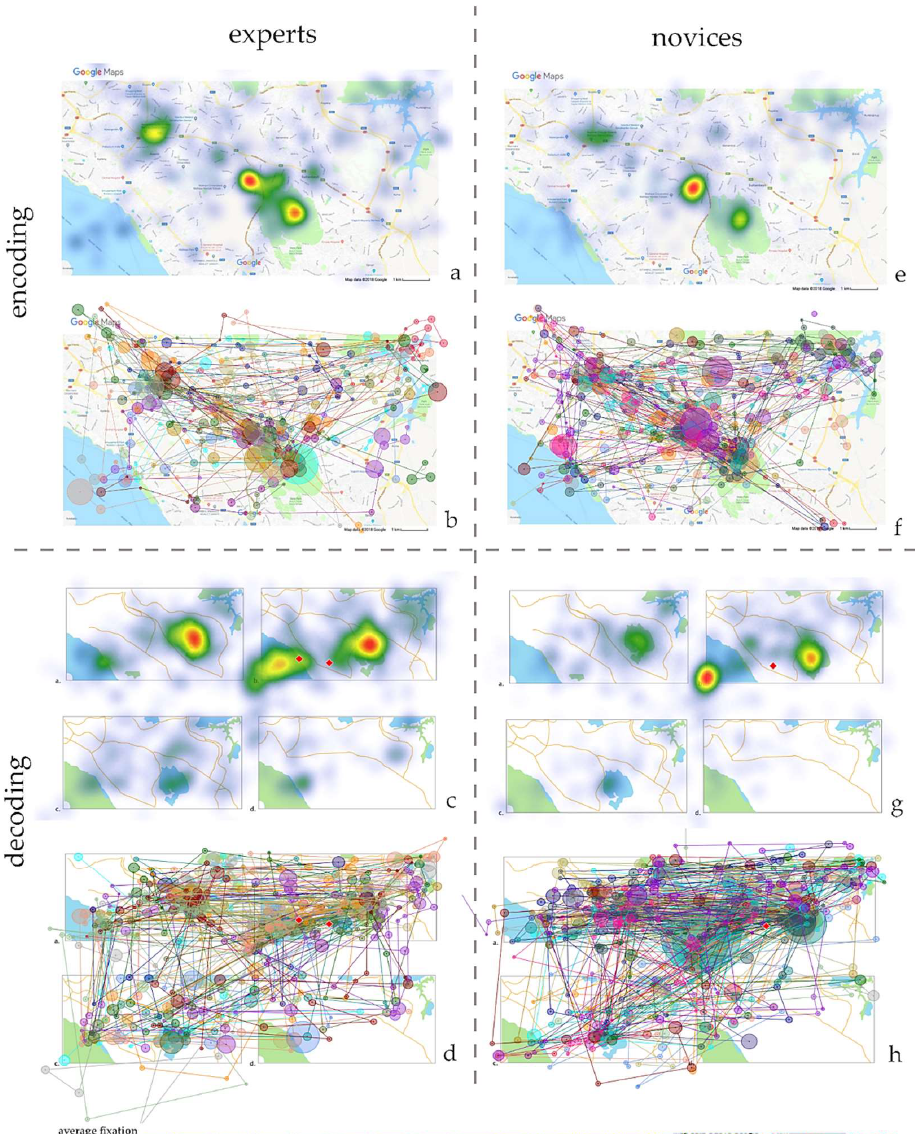
Figure 8. Gaze density maps (‘heatmaps’) and scan paths during encoding and decoding stages for the same map stimulus in Block 1: Original stimulus can be seen in Figure 2. Left: experts (( a , b ): encoding, ( c , d ): decoding). Right: novices (( e , f ): encoding, ( g , h ) decoding). Heatmaps represent average fixation duration (ms); color codes are shown at the very below. For scan paths, 50 px = 500 ms. (A larger version of the map(s) can be seen in Appendix